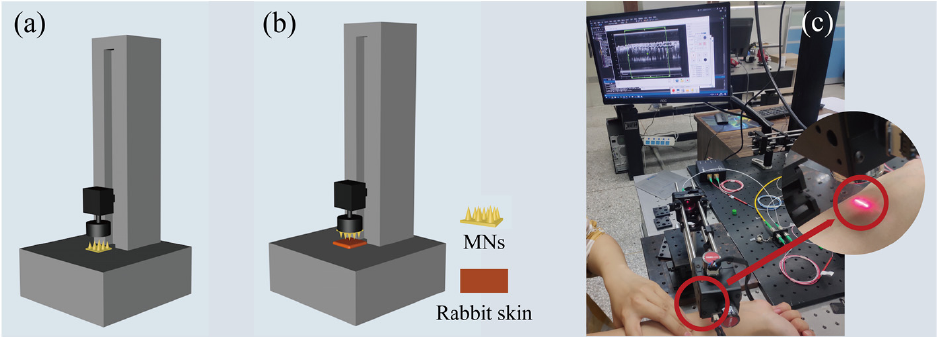
Figure 2. The schematic diagram for processing of mechanical test of melatonin-loaded silk fibroin microneedle (MNs): ( a ) schematic diagram of compression performance test, ( b ) schematic diagram of penetration performance test, and ( c ) schematic diagram of mechanical test process of MN penetration into human skin.